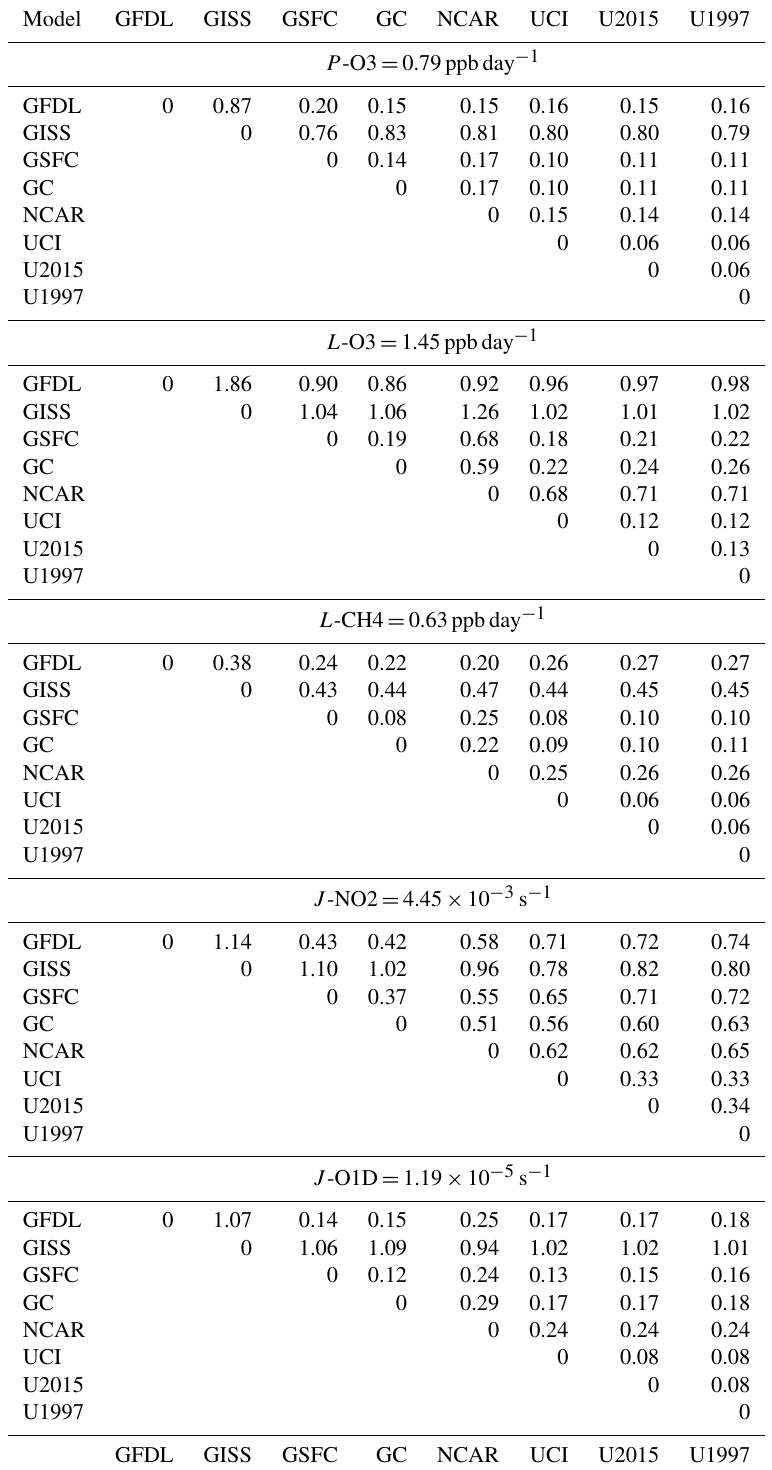
Table 2. RMS differences of 5-day mean parcels across model